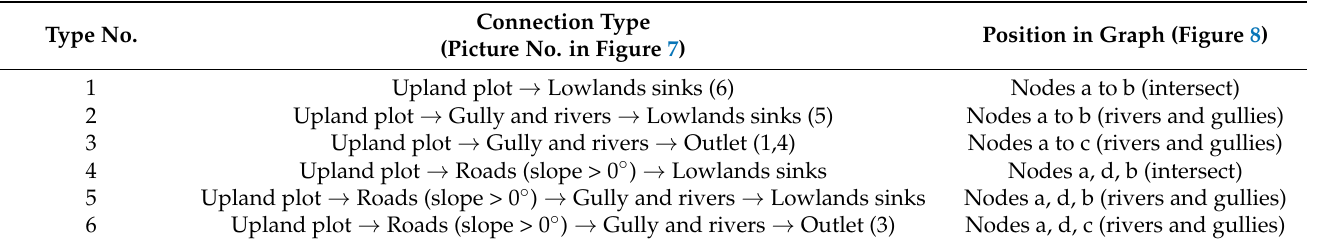
Table 1. Connection types in the study